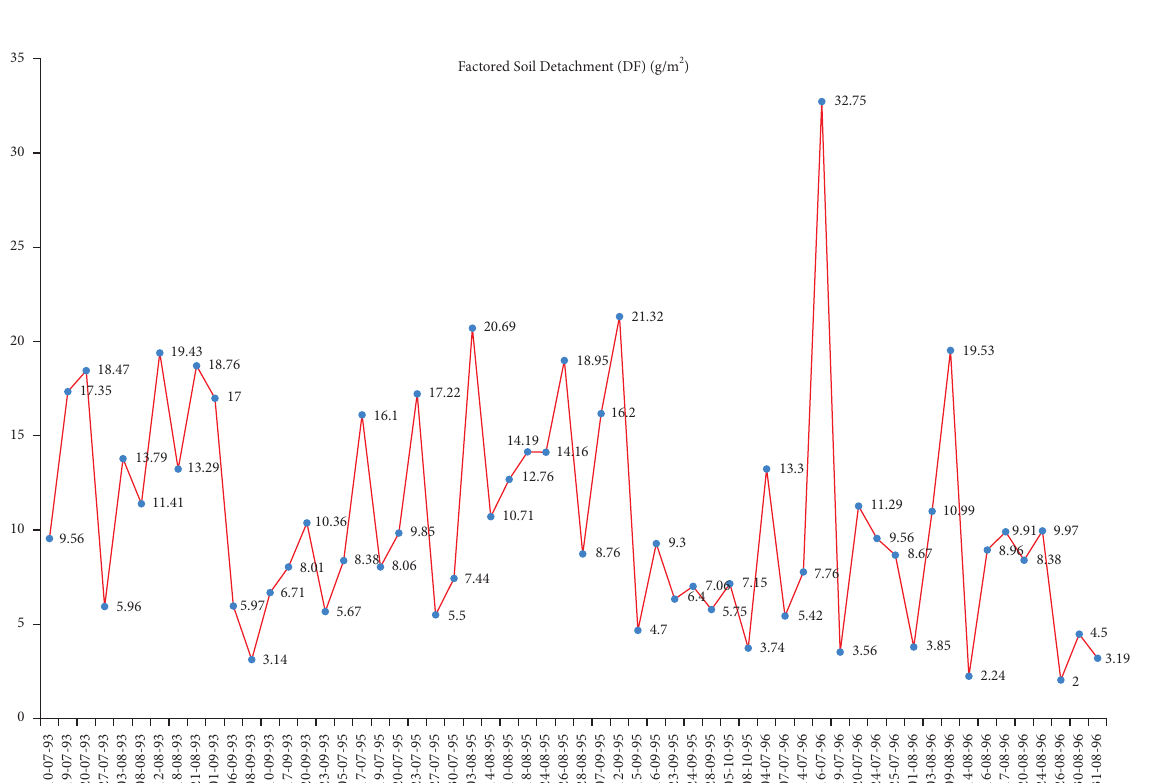
Figure 8: Factored soil detachment with the selected dates of